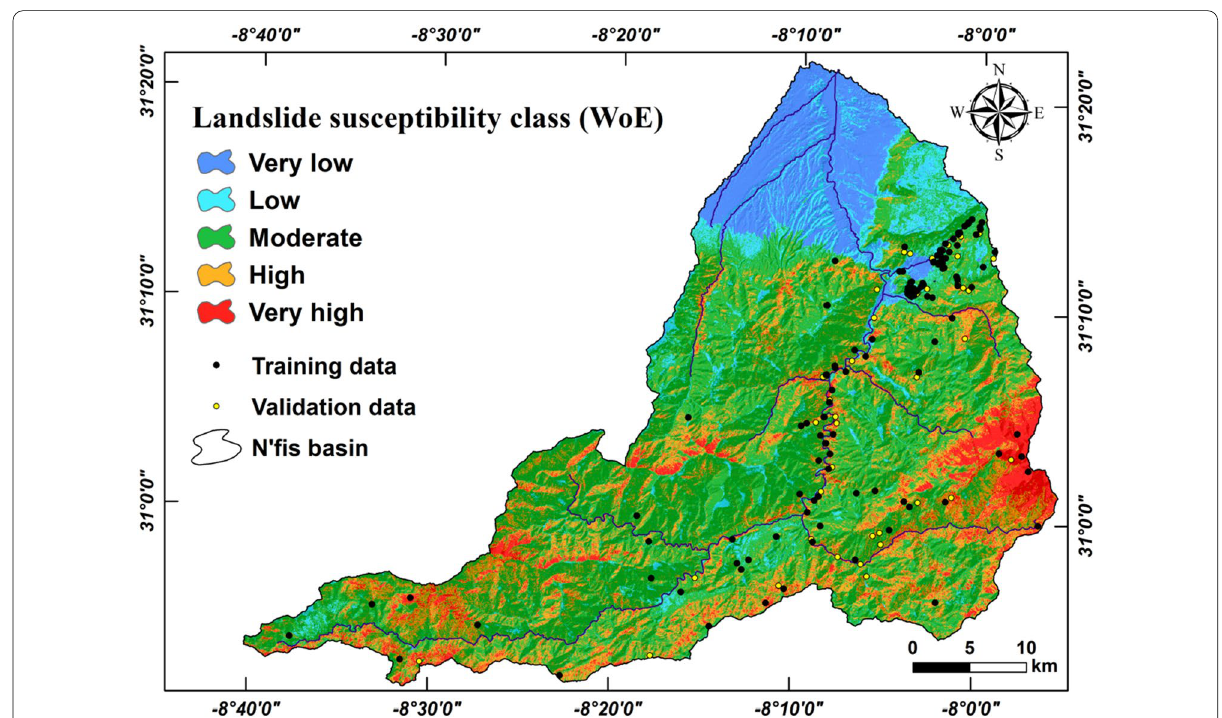
Fig. 6 Landslide susceptibility map using WoE